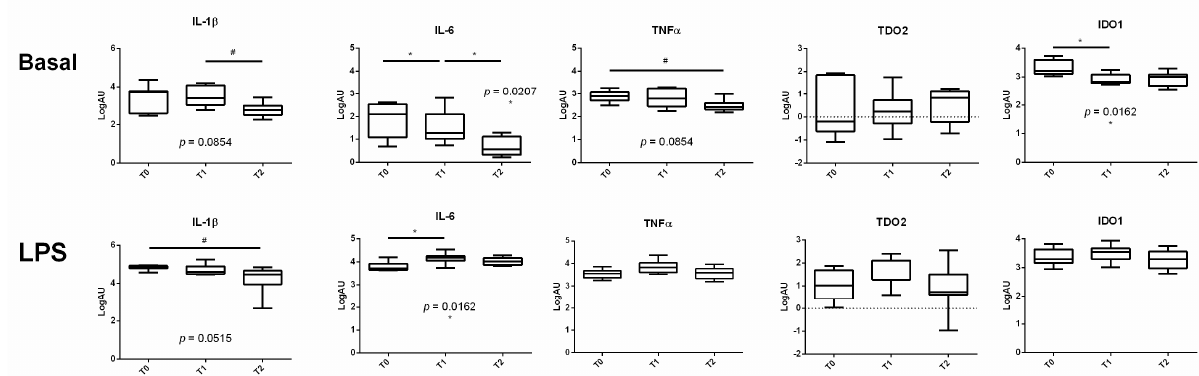
Figure 2. Bovine PBMC gene expression of proinflammatory cytokines and kynurenine molecules at different time points. Bovine PBMCs isolated at 3 different time points (T0 = 15 days before calving; T1 = 7 days post-calving, T2 = 21 days post-calving) were in vitro stimulated with LPS (20 mg/mL) or kept untreated. Gene expression was determined by RT qPCR assay. # p < 0.1, * p < 0.05.